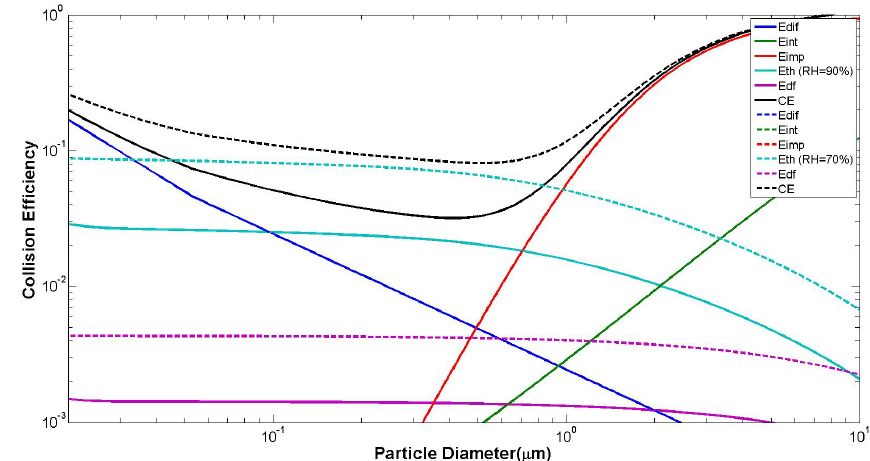
Fig. 2. Theoretical collision efficiency as a function of aerosol radius for a cloud droplet with a radius of 12.8µm and the contribution of each single force. E dif , E int , E imp , E Th and E Df are the collision efficiency due to Brownian motion, interception, inertial impaction, thermophoresis and diffusiophoresis respectively. CE is the total collision efficiency. E Th , E Df and hence CE have been calculated for a relative humidity (RH w ) of 90% (solid lines) and for RH w =70% (dashed lines). The used air temperature was 297.0K, whereas the used droplet surface temperatures were 295.7K and 292.8K at a RH w of 90% and 70%, respectively.